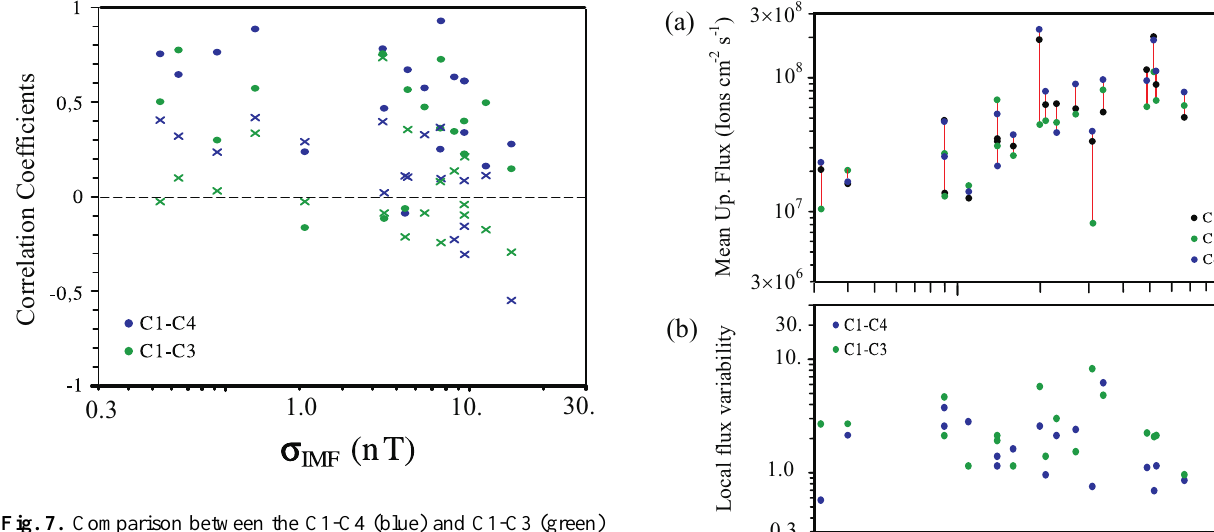
Fig. 7. Comparison between the C1-C4 (blue) and C1-C3 (green) cross correlation coefficients of the upward mean velocity (filled circles) and the ionospheric convection drift (crosses) as a function of the IMF variability in nT.